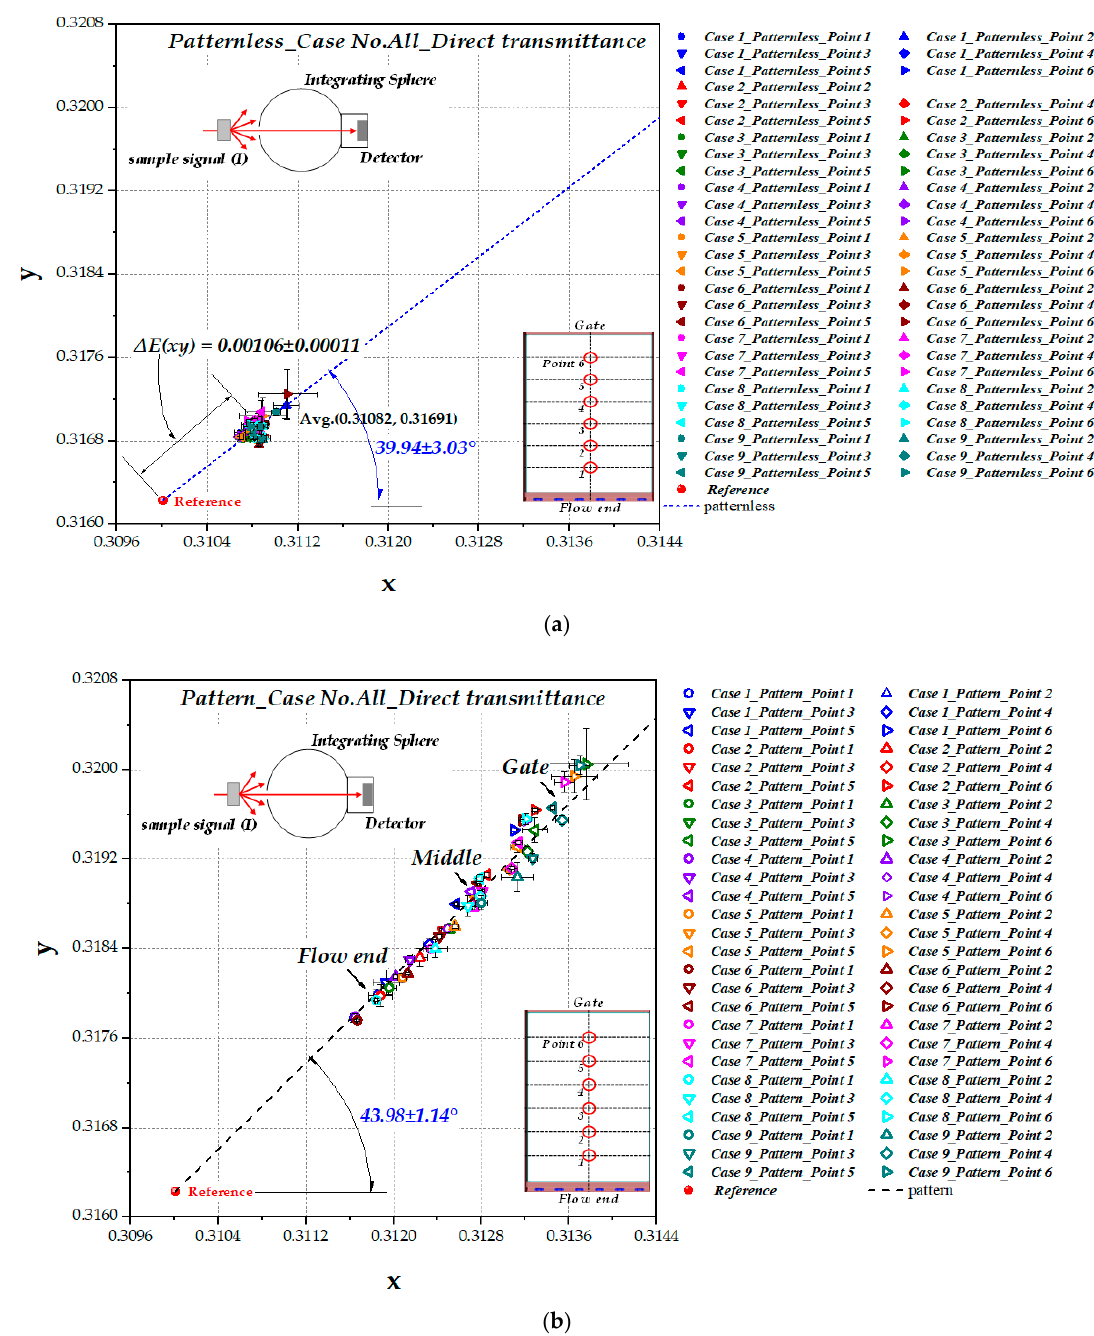
Figure 8. The representation of color shift from direct transmittance shown in CIE1931 color space: ( a ) patternless LGP (all 9 cases); ( b ) patterned LGP (all 9 cases).